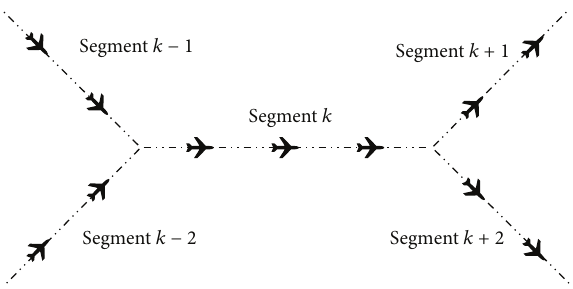
Figure 3: Converging and diverging of air traffic